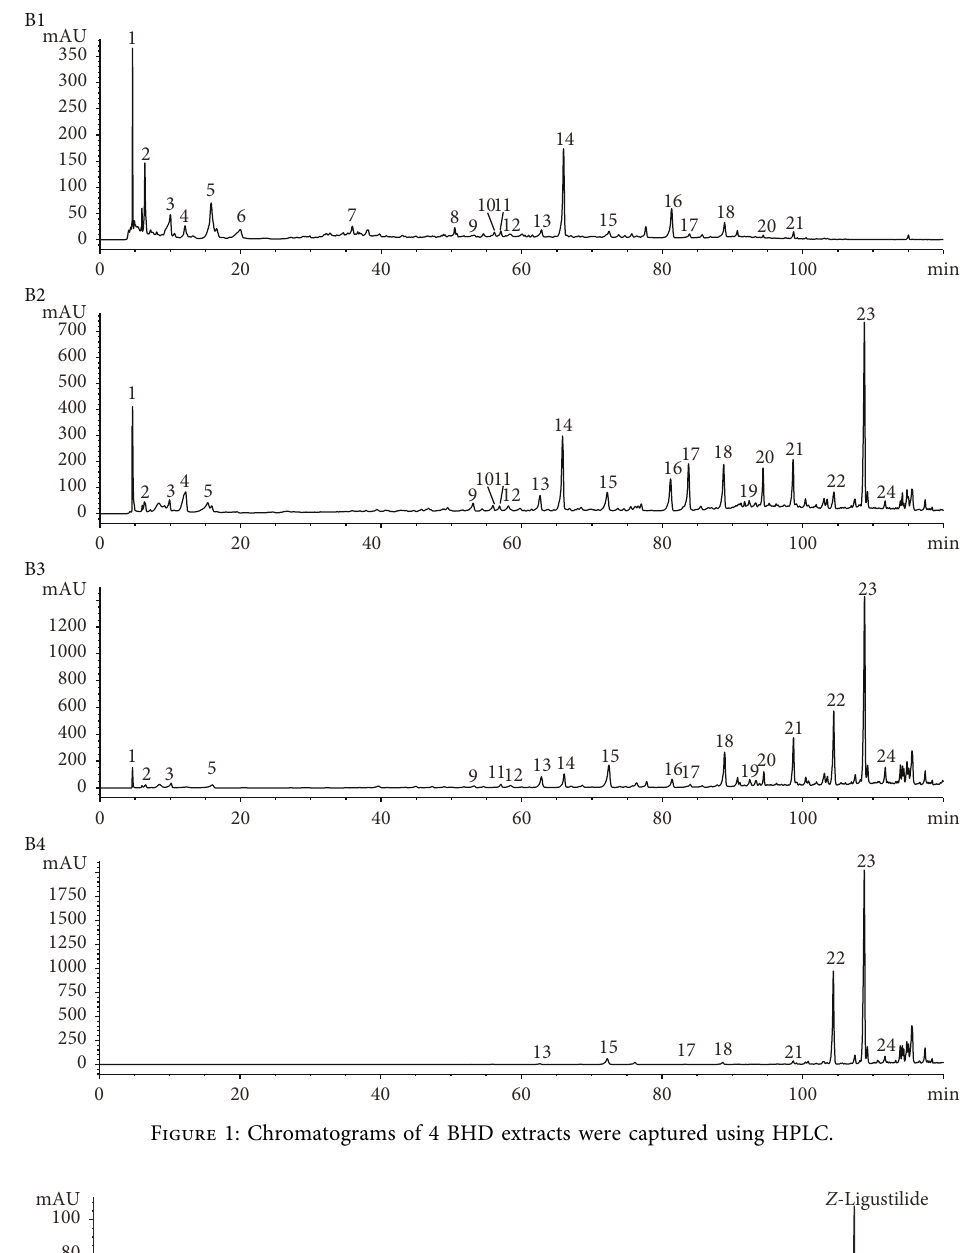
Figure 1: Chromatograms of 4 BHD extracts were captured using HPLC.